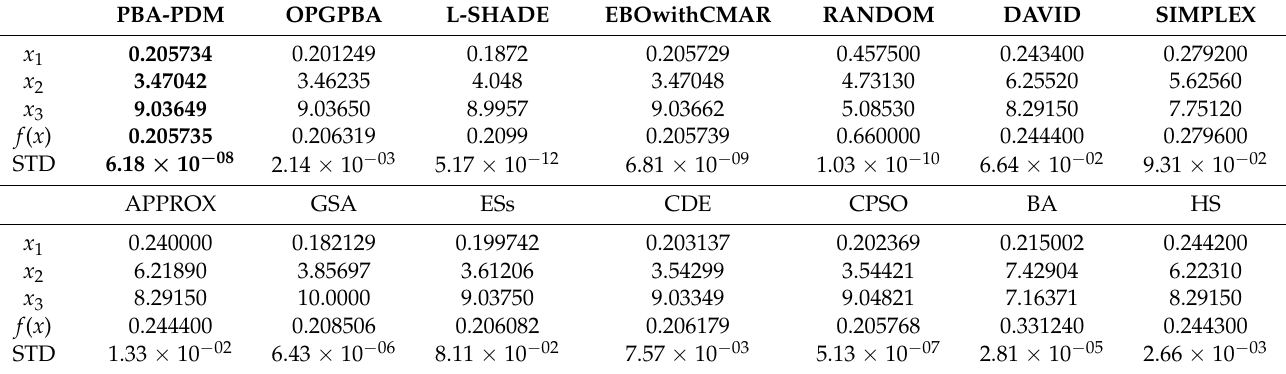
Table 15. The comparison of PBA-PDM with other optimizers in Welded Beam Design.